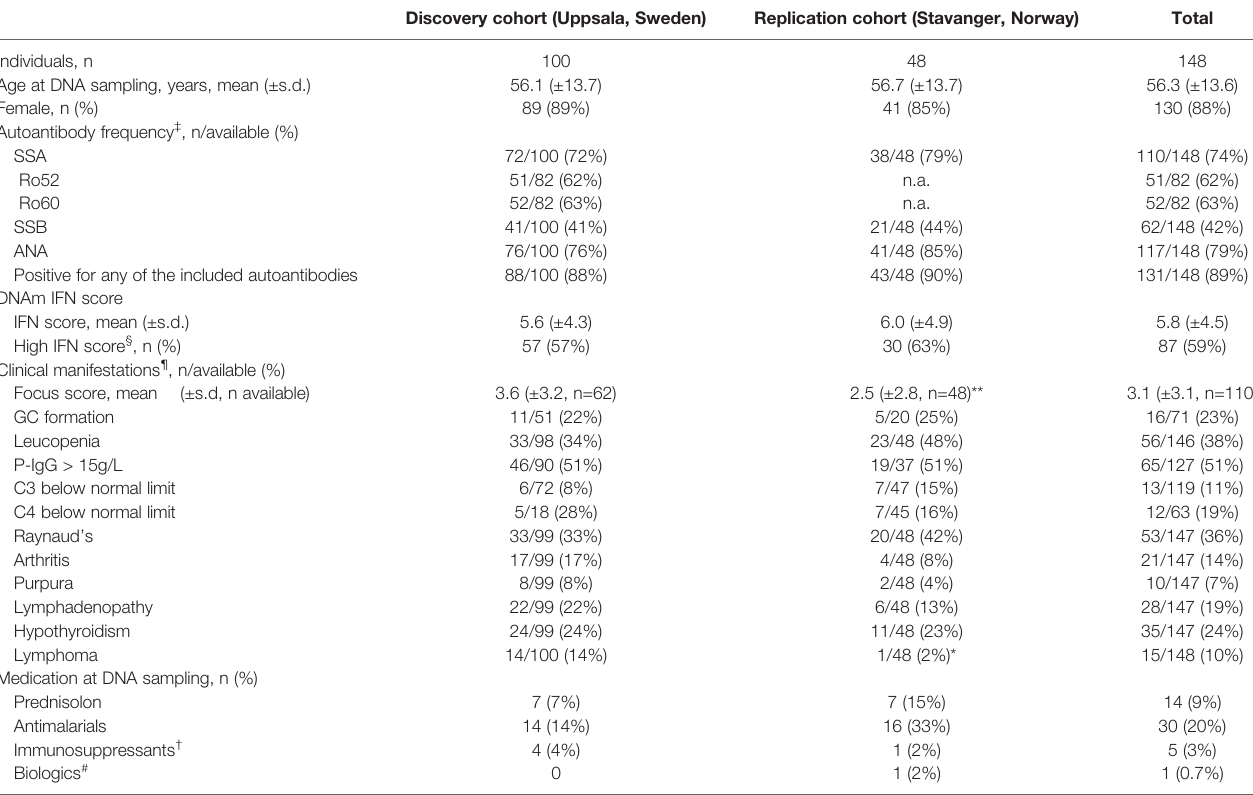
TABLE 1 | Demographic and clinical characteristics of patients with primary Sjögren ’ s syndrome (pSS) included in the discovery cohort and the replication cohort. Discovery cohort (Uppsala,